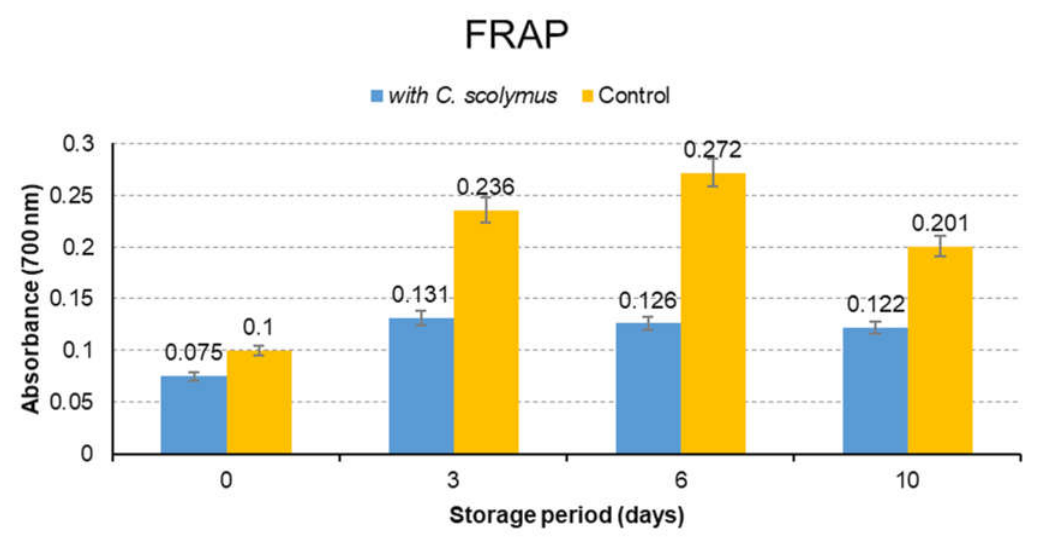
Figure 5. The antioxidant activity of control and marinated meat samples (FRAP assay).